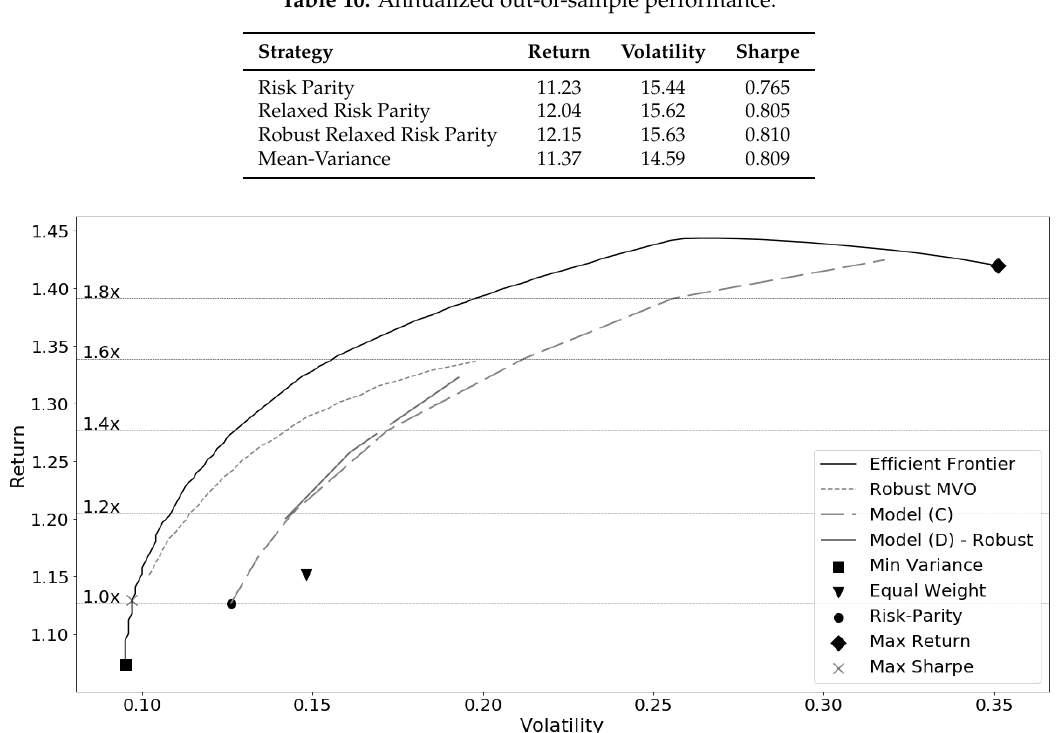
Table 10. Annualized out-of-sample performance.